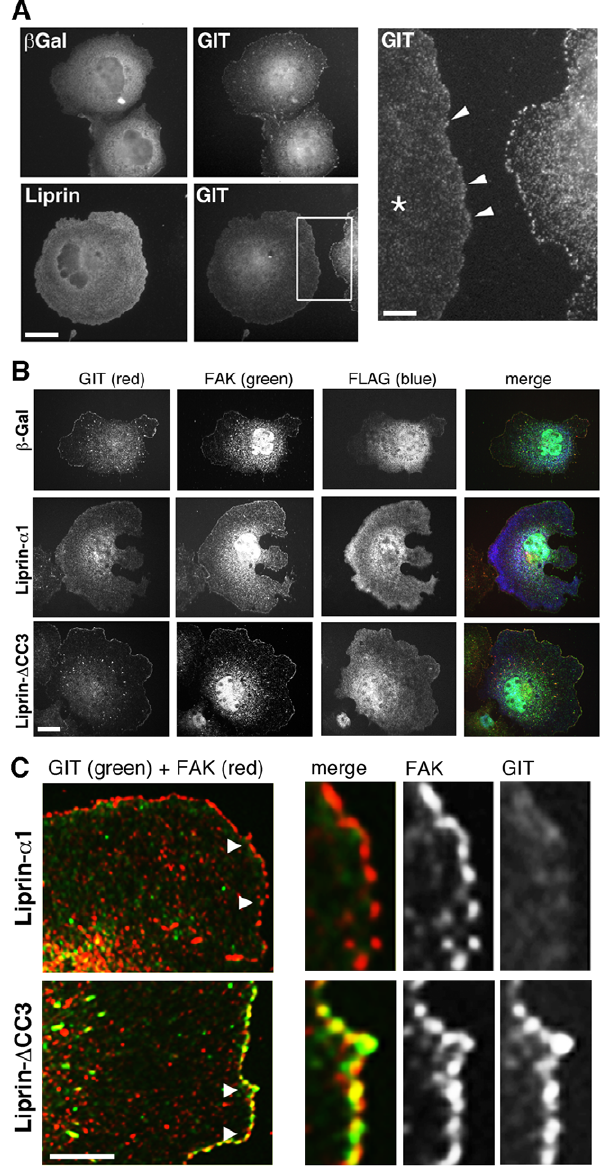
Figure 3. Liprin- a 1 affects the subcellular localization of endogenous GIT. (A) Overexpression of liprin- a 1 affects the localization of endogenous GIT at peripheral FAs. COS7 cells overexpressing either FLAG-liprin- a 1 or FLAG- b galactosidase were plated for 1 h on FN and immunostained for the transfected protein and for endogenous GIT. Scale bar, 20 m m. Right panel: four-fold enlargement of the boxed field; liprin- a 1 overexpression (cell with asterisk) reduces the accumulation of GIT at newly formed FAs at the edge of transfected cells (arrowheads). Scale bar, 5 m m. (B) Cells transfected with FLAG- b galactosidase, FLAG-liprin- a 1, or FLAG-liprin- D CC3 were plated for 1 h on FN before fixation and staining for the transfected protein and for endogenous GIT and FAK proteins. Scale bar, 20 m m. (C) High magnification of the edge of transfected cells showing that endogenous GIT overlaps well with FAK at peripheral FAs of FLAG-liprin- D CC3 transfected cells, while poor overlap between endogenous GIT and FAK is seen at peripheral FAs of FLAG-liprin- a 1 expressing cells. Scale bar, 10 m m. Panels on the right are 3-fold enlargements of the areas indicated by arrowheads in the correspond- ing images on the left.